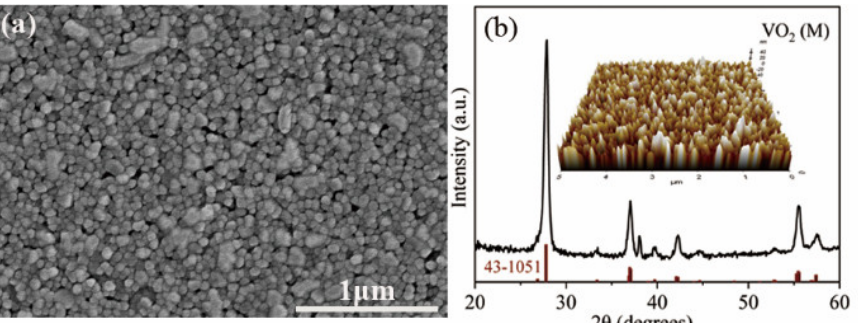
Figure 5. ( a ) SEM micrographs of the VO 2 film deposited on the sapphire substrate; ( b ) XRD patterns of VO 2 film (thickness: 260 nm), and the inset AFM image shows Ra = 8.6 nm measured by the software XEI Analysis with a scanning area of 5 µ m × 5 µ m.